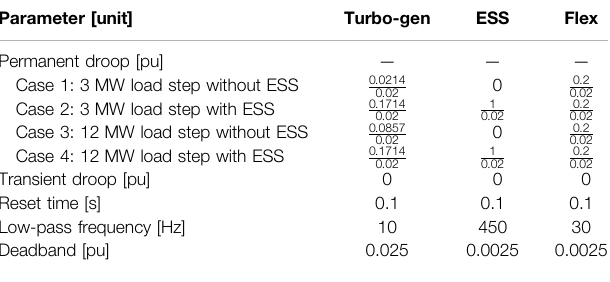
TABLE 3 | Parameters of the primary controllers used during the